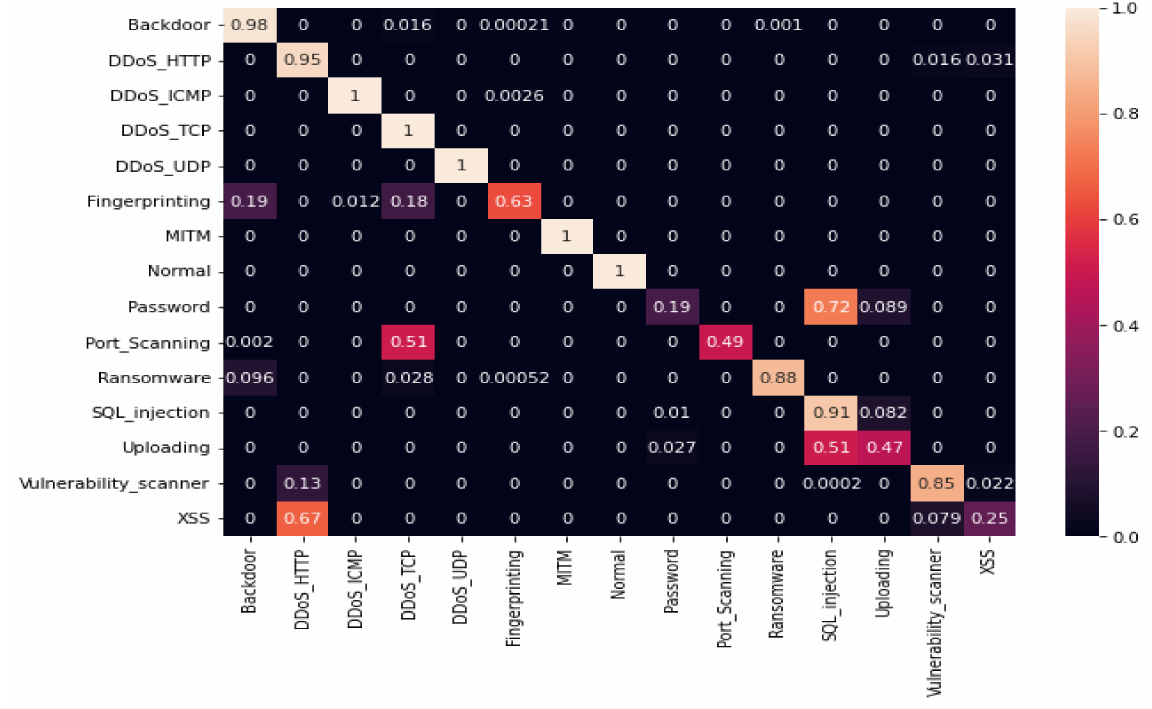
Figure 11. The results of Inception Time and multi-class classification of the Edge-IIoT dataset.